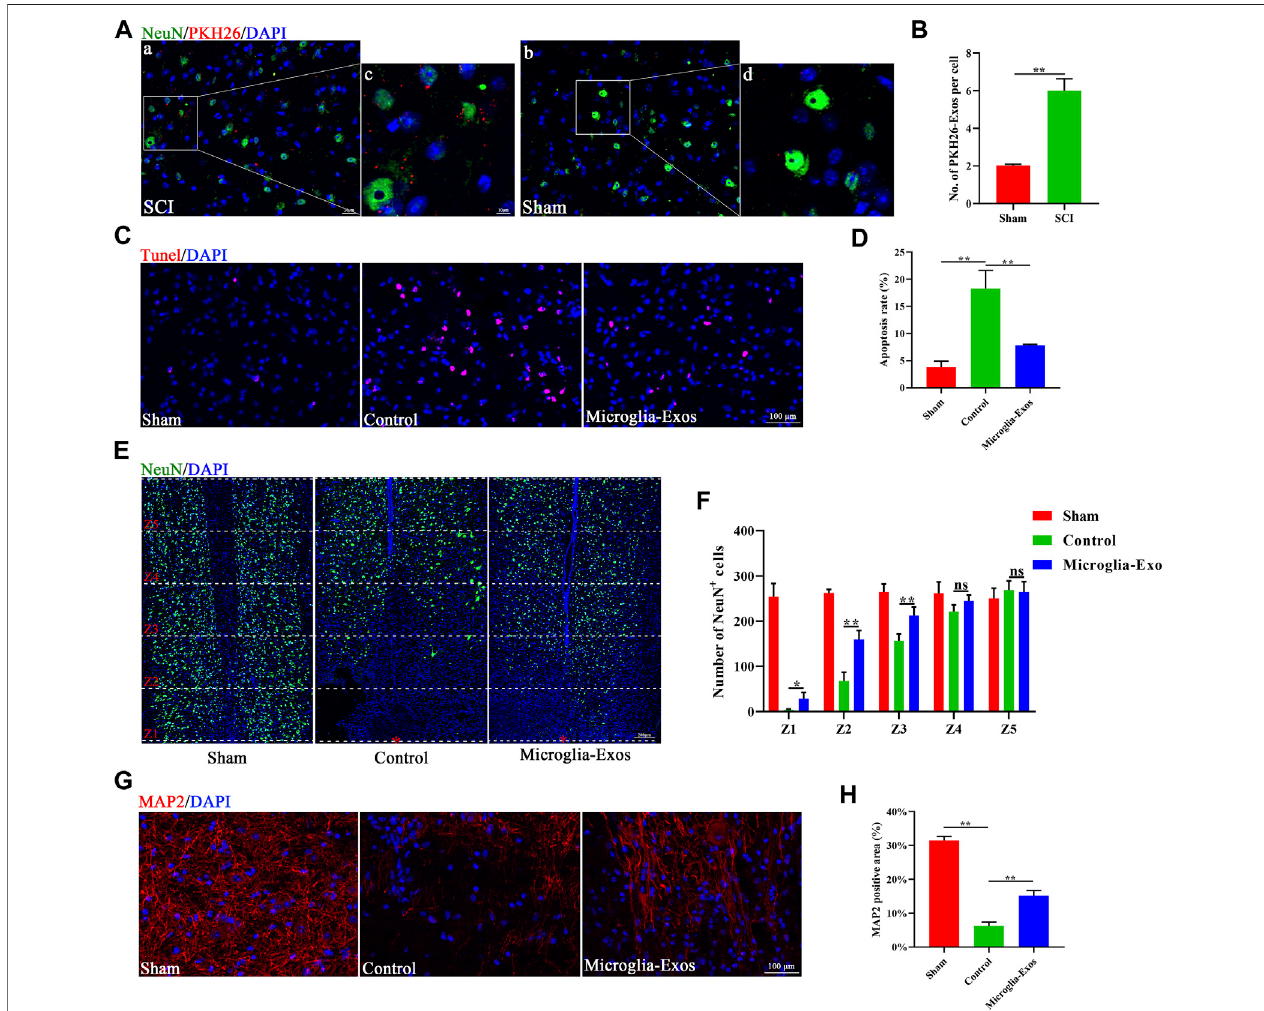
FIGURE4 | Microglia-Exos lessen neuron loss and facilitate axongrowth by suppressing neuron apoptosis .(A) Representative images of exosomes (PKH26, red) uptaken by neurons in sham and SCI groups. Scale bar: a, b (20 μ m) and c, d (10 μ m). (B) Quanti fi cation of number of PKH26-exos per cell in (A) . N (cid:1) 3 per group. (C) Representative images of TUNEL staining of sham, control, and Microglia-Exo – treated groups. Scale bar: 100 μ m. (D) Quanti fi cation of the apoptosis rate in (C) . N (cid:1) 5 per group. (E) Representative staining images of NeuN (green) of sham, control, and Microglia-Exo – treated groups at different zones. The red star indicates the epicenter of the injury site. Scale bar: 200 μ m. (F) Quanti fi cation of number of NeuN-positive cells at different zones in (E) . N (cid:1) 5 per group. (G) Representative staining imagesofMAP2(red)ofsham, control,and Microglia-Exo – treatedgroups.Scalebar:100 μ m. (H) Quanti fi cationoftheMAP2-positiveareain (G) .N (cid:1) 5per group.Data are presented as the mean ± SD. * p < 0.05, ** p < 0.01, ns (cid:1) not signi fi cant.